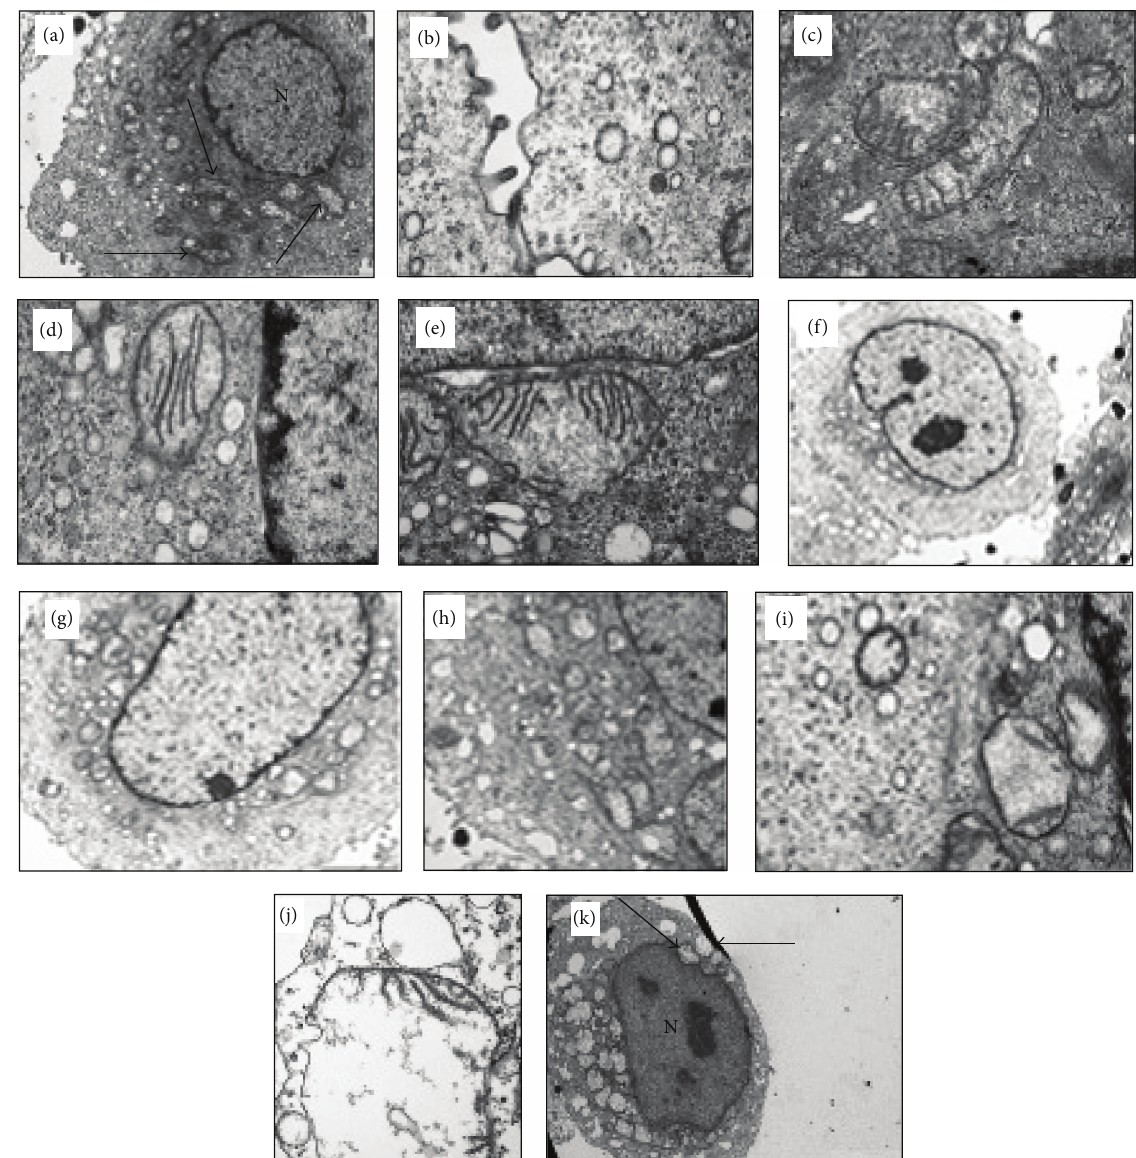
Figure 1: TEM of S. typhimurium at 1hr (a–e), 4hrs (f–i), and 8 hrs (j and k) displaying various degrees of mitochondria destruction as a result of Salmonella infestation. In (a), mitochondria are shown (arrows) in which most of the cristae are destroyed. (c) through (e) show mitochondria with degraded cristae. (k) shows mitochondria within the PC-3M cell in which mitochondria (arrows) appear to be empty while the nucleus (labeled “N”) does not appear to be affected